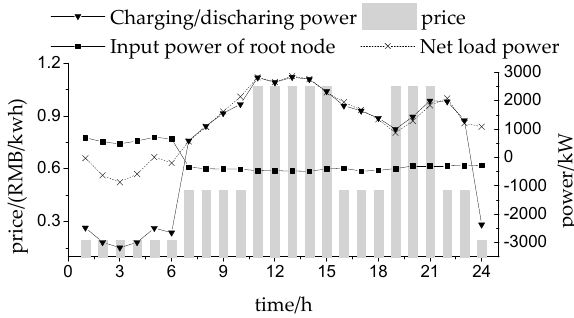
Figure 7. The curves of the ESS charge power and the power supplied by the distribution network.